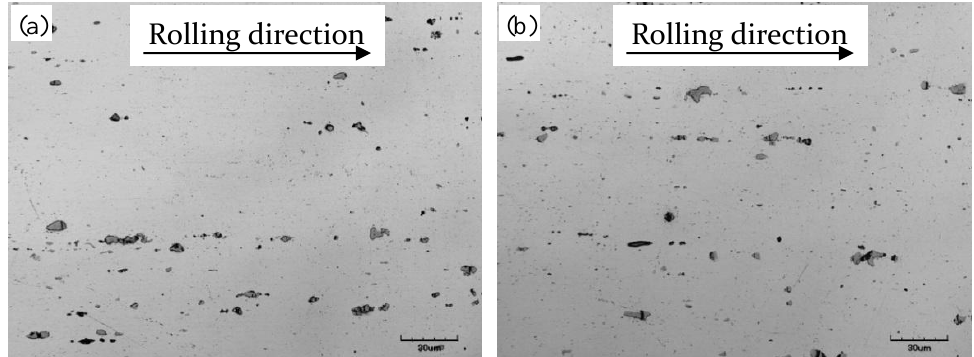
Figure 3 . Optical micrograph of ( a ) annealed and ( b ) quenched 5083 aluminum alloy sheets.